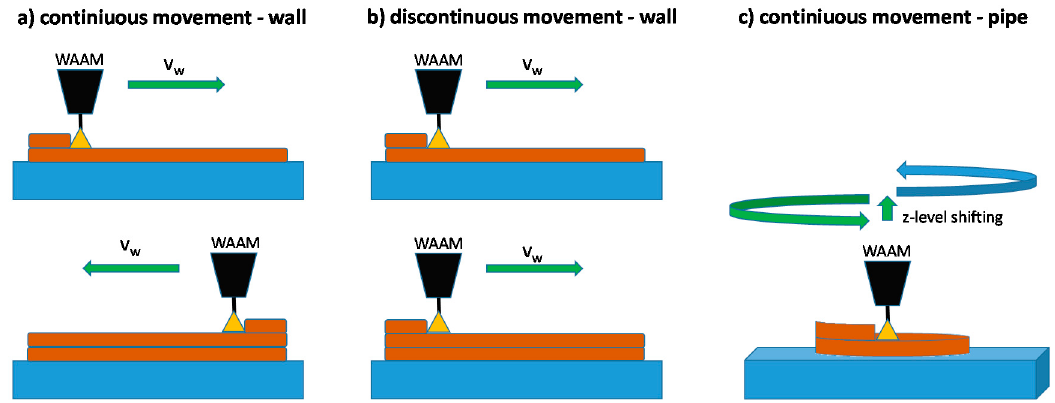
Figure 5. Scheme of the handling processes with continuous or discontinuous movement (left side: wall, right side: pipe).